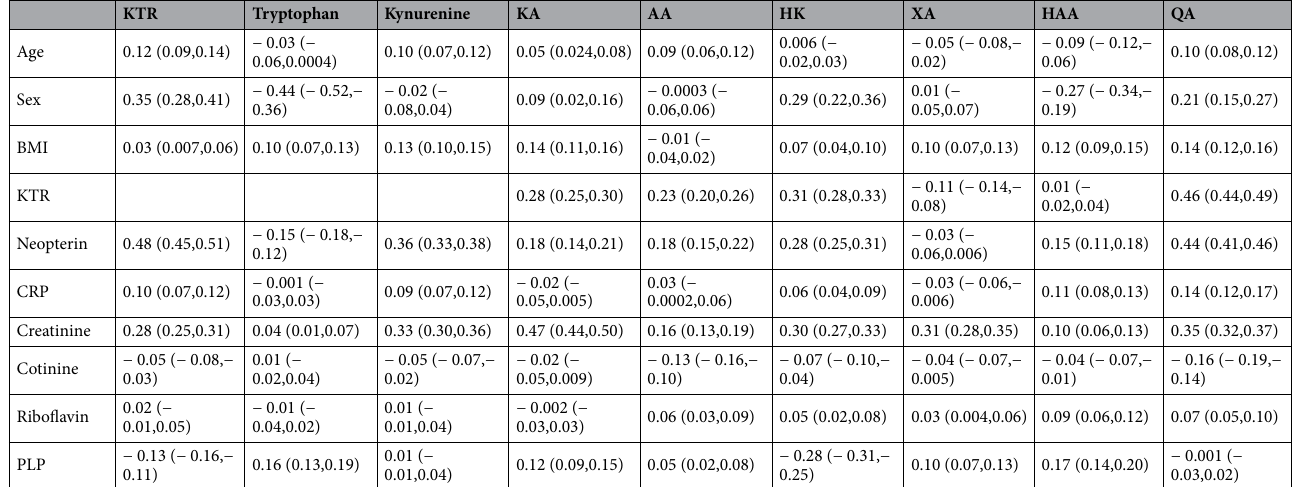
Table 2. Predictors of kynureniners and KTR by mixed models. The numbes given are regression coefficients with 5,95% CI. The models were calculated by including cohorts and regions as random effects, and age, sex, BMI, CRP, KTR or neopterin (KTR and neopterin were included in separate models), creatinine, cotinine, riboflavin, PLP and sample storage time as fixed effects. All continuous variables were log-transformed and then centered on the mean and standardized by dividing by the standard deviation. For sex the regression coefficients represent the ratio of biomarker levels for women vs men. AA: anthranilic acid; BMI: body mass index; CRP: C-reactive protein; HAA: 3-hydroxyanthranilic acid; HK: 3-hydroxykynurenine; KA: kynurenic acid; KTR: kynurenine/tryptophan ratio; PLP: pyridoxal 5 ′ -phosphate; QA: quinolinic acid; XA: xanthurenic